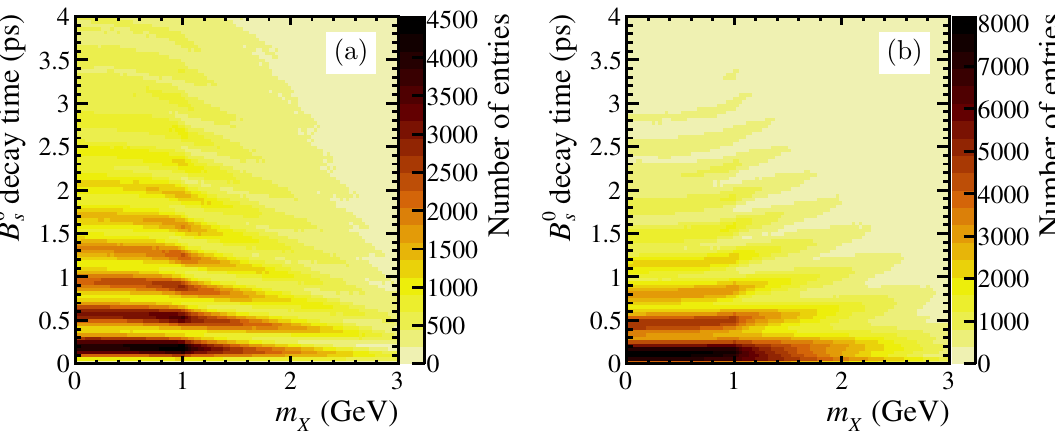
Figure 3 . B 0 decay time reconstructed from decay length using p (min) s as a function of the mass m X used in topological reconstruction. The true mass of the X state is M X = 1